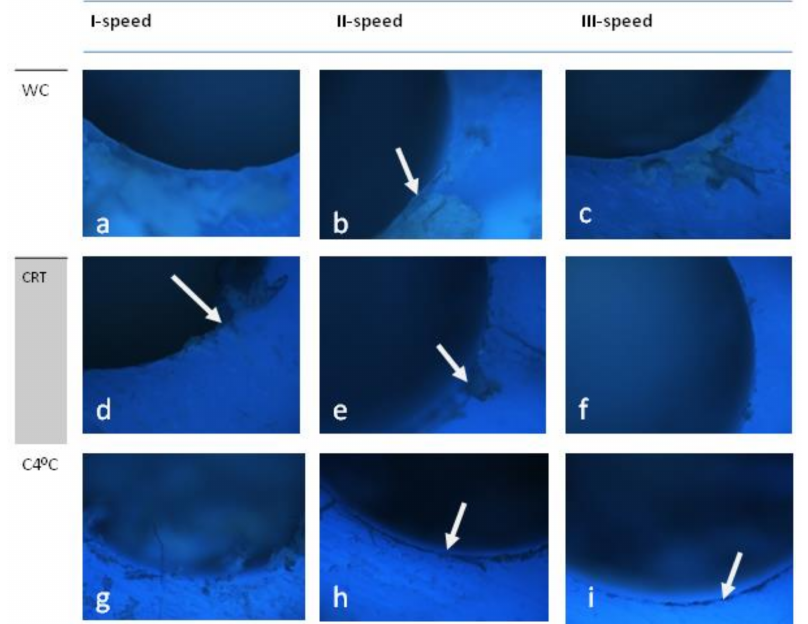
Figure 4. Drill-S-wide. The surfaces of holes drilled at different speeds (I-800 rpm, II-1000 rpm, III-1200 rpm) and using different cooling methods. Note the different smoothness and signs of carbonization (arrow). WC-without cooling, CRT-cooling at room temperature, C4 ◦ C cooling at 4 ◦ C. Autofluorescence. Mag. x40. ( a – c ) WC-without cooling, ( d – f ) CRT-cooling at room temperature, ( g – i ) C4 ◦ C cooling at 4 ◦